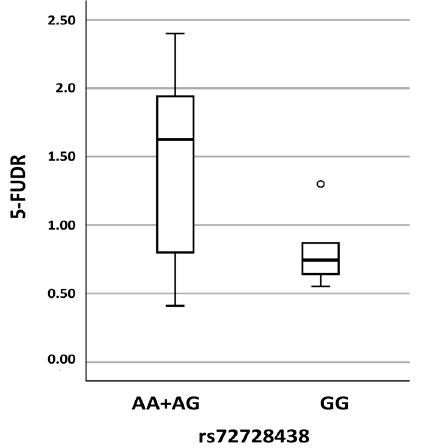
Figure 3. 5-FUDR values distribution in subjects with the AA or AG genotype compared to subjects with the GG genotype in the polymorphic site c.1974+75A>G (rs72728438).